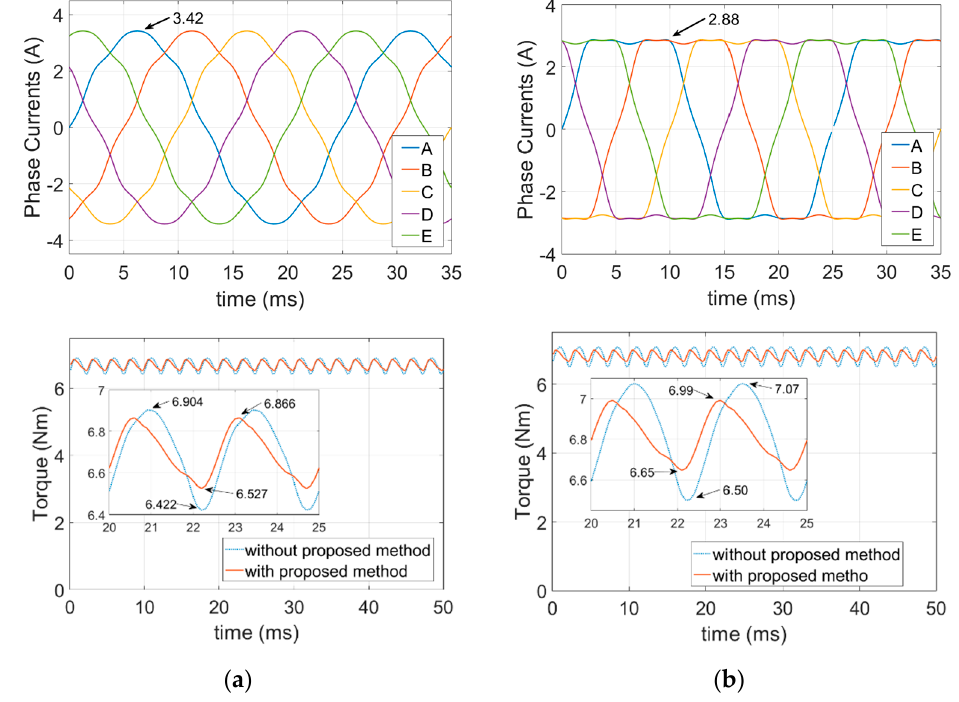
Figure 10. FEA torque waveforms for the Healthy1 condition with and without proposed method: ( a ) Only fundamental ; ( b ) fundamental plus third harmonic.